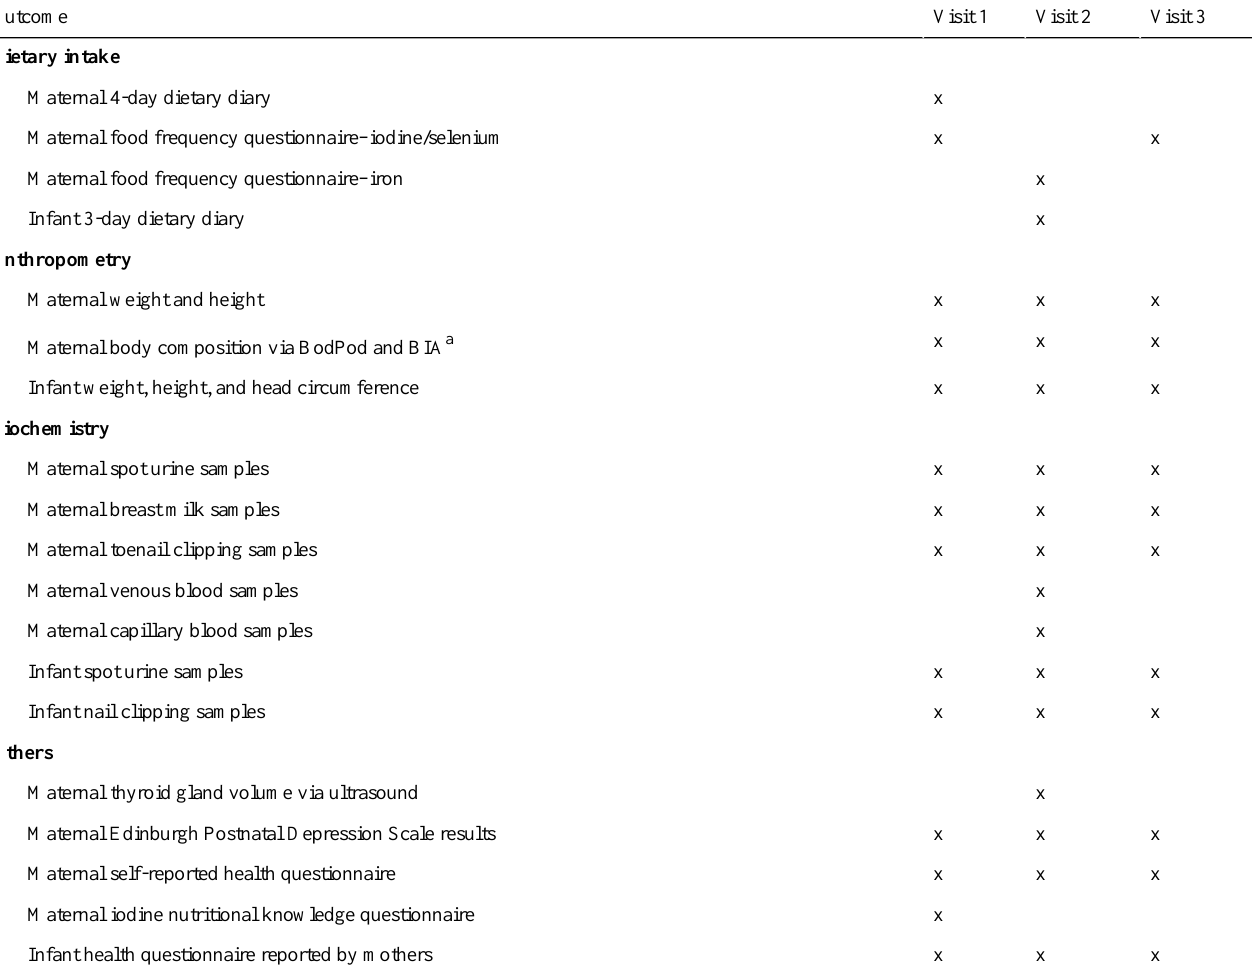
Table 1. Summary of outcome measures collected from participating women and their